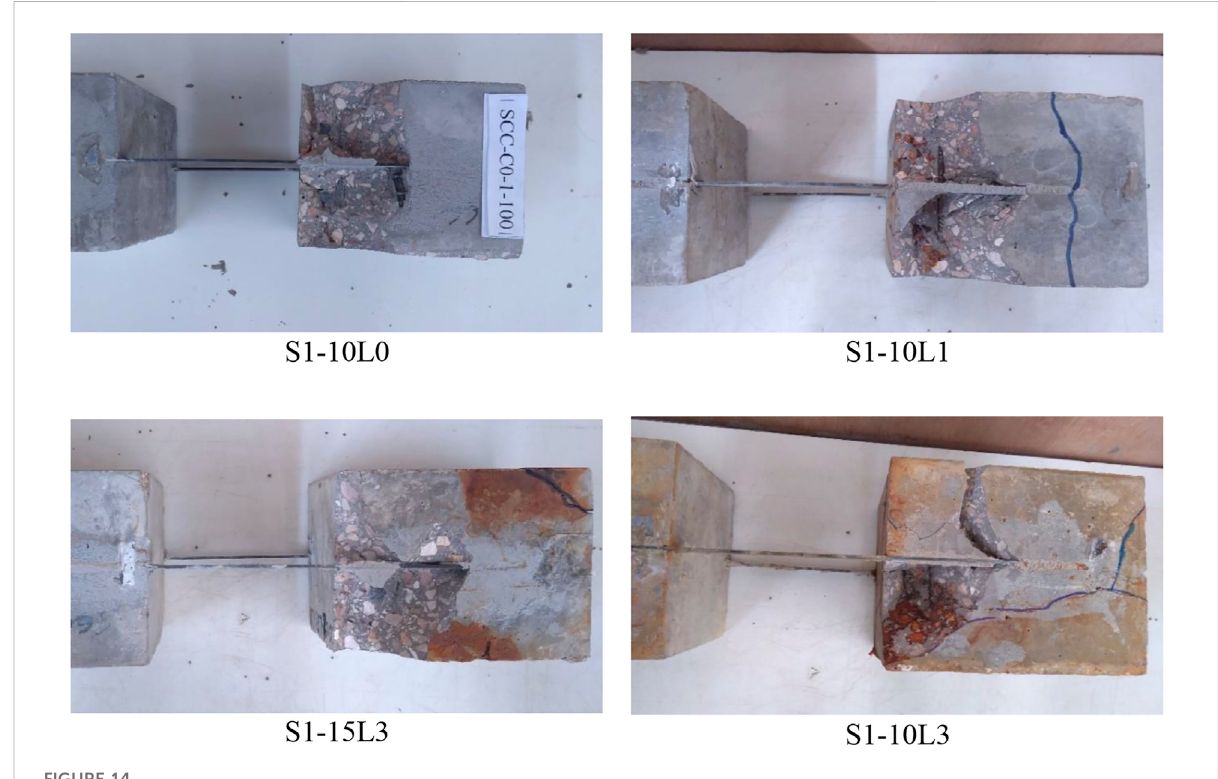
FIGURE 14 Failure mode of the NSM bond with concrete.